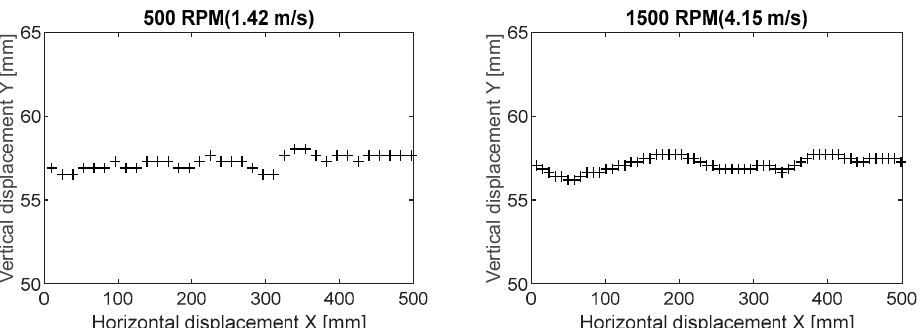
Figure 11. Vertical displacement of the measurement point as a function of horizontal displacement (distance traveled).